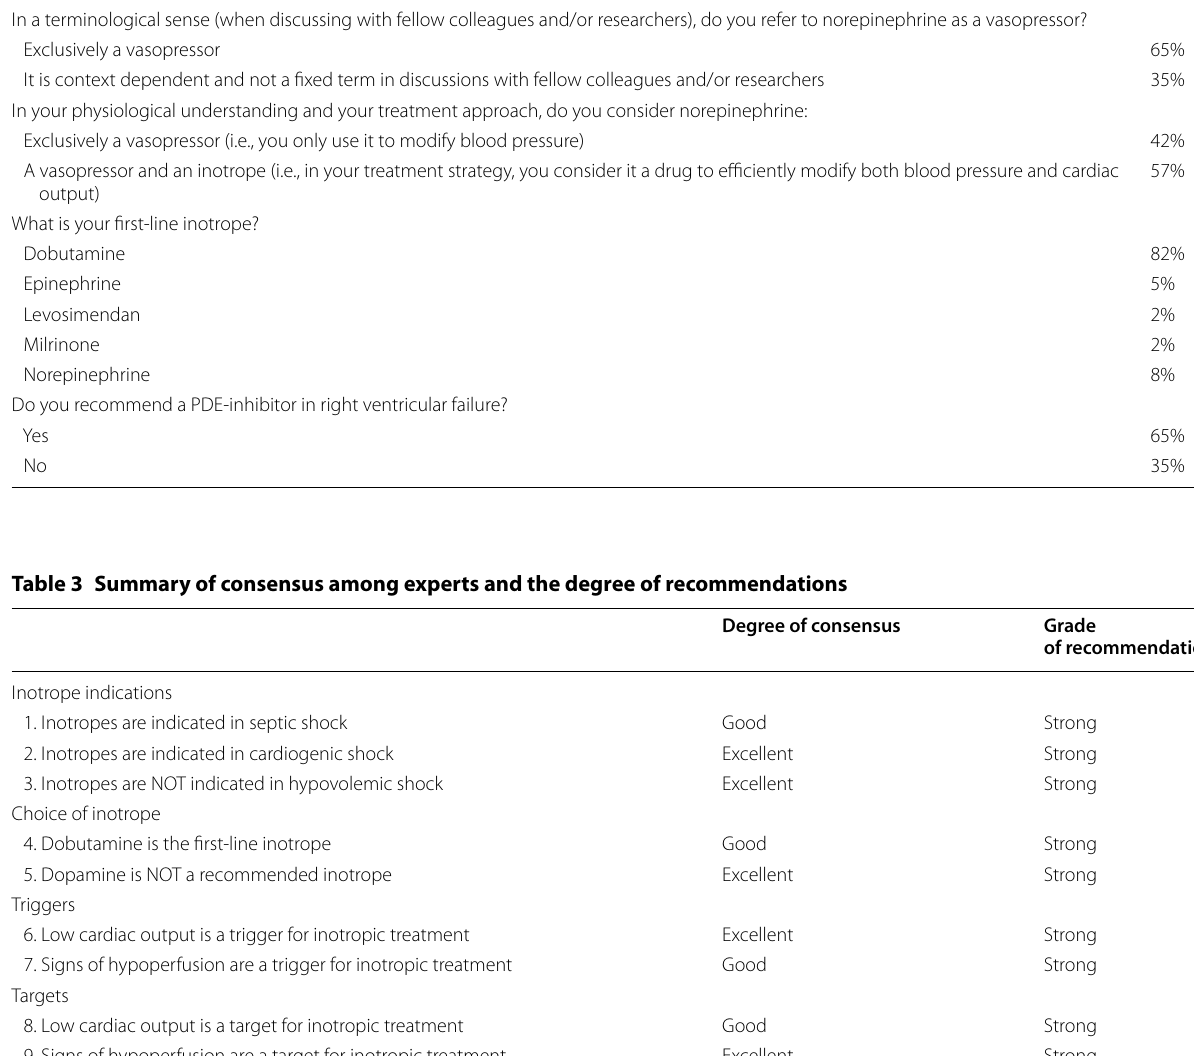
Table 2 Second round questionnaire to 40 experts on inotrope use Question